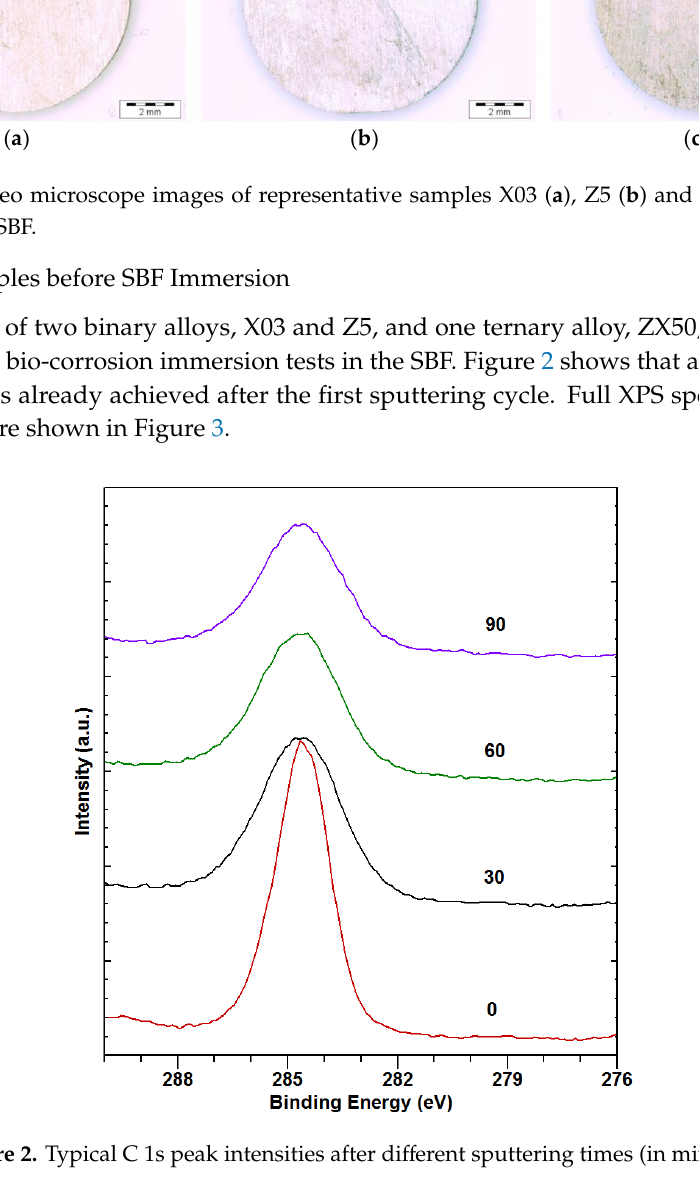
Figure 2. Typical C 1s peak intensities after different sputtering times (in minutes).